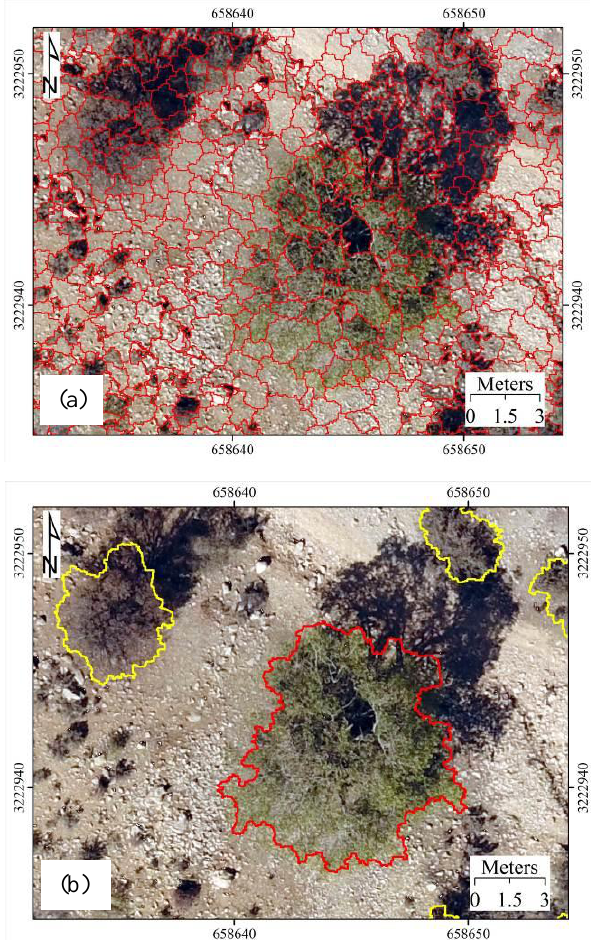
Figure 6. Segmentation used to discriminate crowns of wild pistachio trees and wild almond shrubs on the UAV orthoimagery. (a) A sample of splitting the UAV orthoimagery into segments, (b) The results of merging the segments to obtain vector map of crowns of studied species (red polygon: wild pistachio, yellow polygons: wild